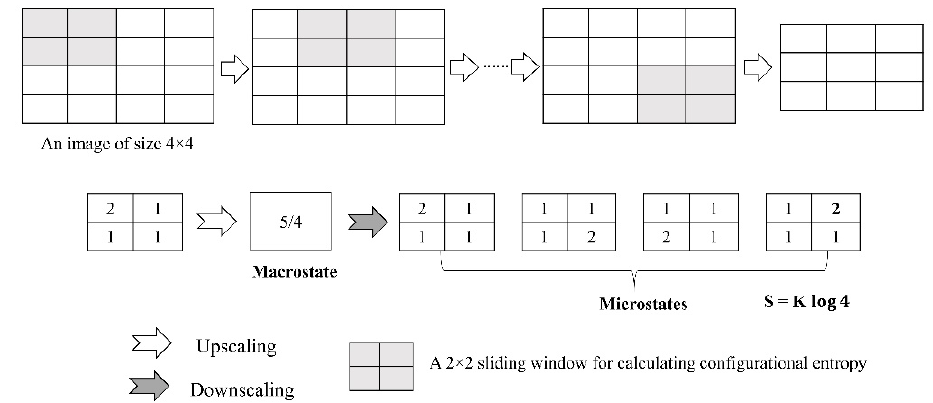
Figure 3. An example of computing the configurational entropy.